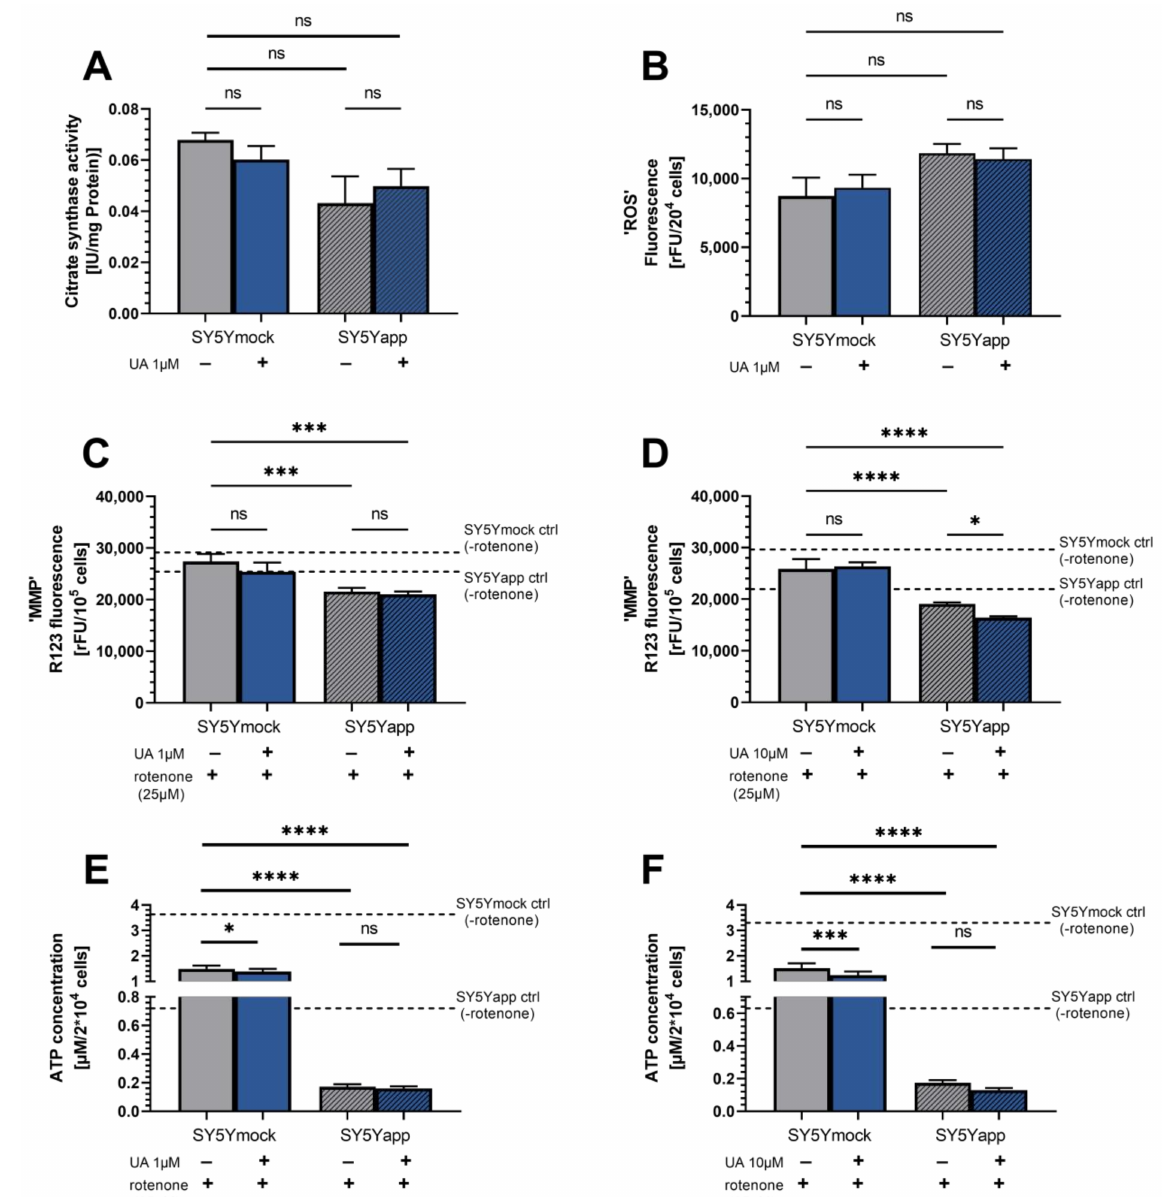
Figure 3. ( A ) Citrate synthase activity of SY5Ymock and SY5Y-APP695 samples. Cells were incubated with either 1 µ M UA or its DMSO control (ctrl). Enzyme activity waws adjusted to protein content of the samples. N = 7–13. ( B ) ROS level measured in form of DCFDA/H2DCFDA fluorescence in SY5Ymock and SY5Y-APP695 cells. N = 8; ( C , D ) Mitochondrial membrane potential of SY5Ymock and SY5Y-APP695 cells treated with 1 µ M UA ( C ) or 10 µ M UA ( D ) whose complex I activity was inhibited via addition of 25 µ M rotenone. Dashed line corresponds to MMP of uninhibited SY5Ymock/APP695 control cells. N = 7–11; ( E , F ) ATP levels of SY5Ymock and SY5Y-APP695 cells treated with 1 µ M UA ( E ) or 10 µ M ( F ) whose complex I activity was inhibited via addition of 25 µ M rotenone. The dashed line shows the basal ATP level of SY5Ymock/- APP695 cells not treated with 20 µ M rotenone. Dashed line corresponds to MMP of uninhibited SY5Ymock/APP695 control cells. N = 7–14; Displayed are means ± SEM. Statistical significance was tested via one-way ANOVA followed by a false discovery rate correction according to Benjamini, Krieger and Yekutieli. Significance is displayed as: ns p > 0.05, * p < 0.05, *** p < 0.001 and **** p < 0.0001. List of all statistical parameters and comparisons can be found in Supplementary Table